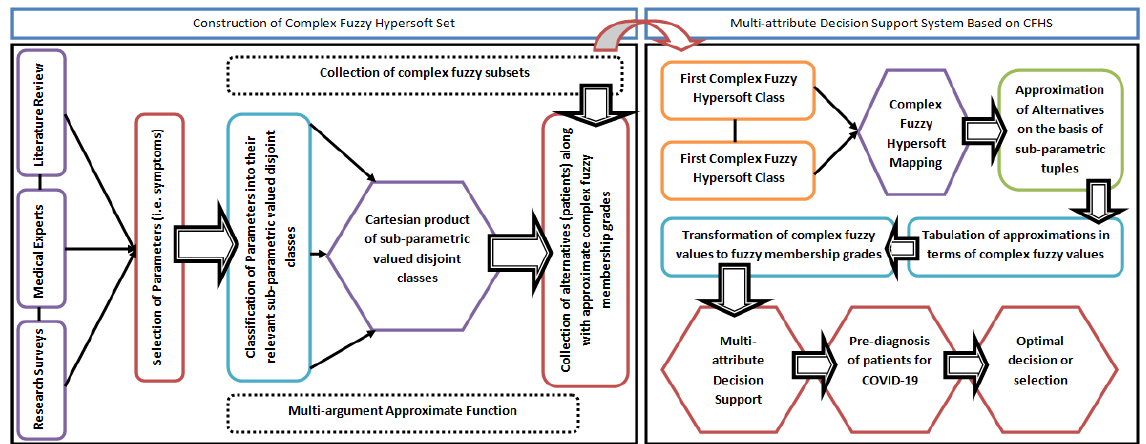
Figure 1. Pictographic view of various stages involved in adopted